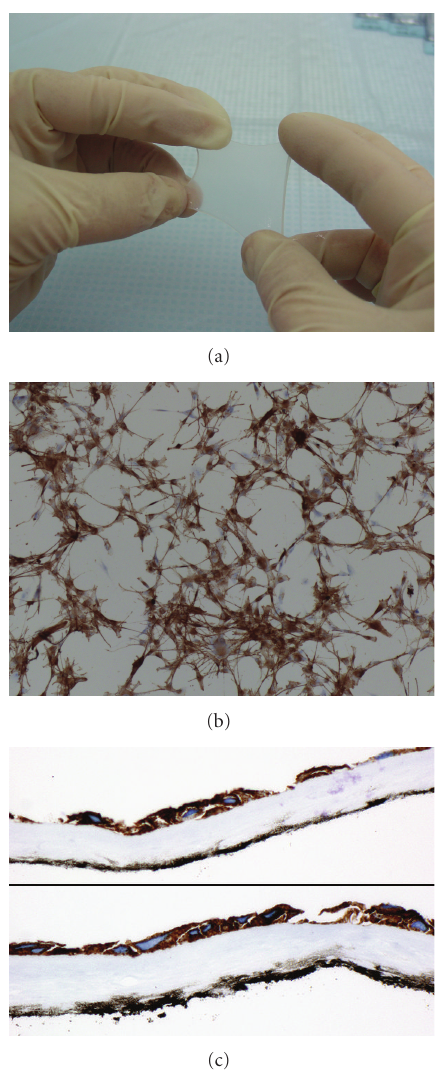
Figure 1: Piece of amniotic membrane (a); immunohistochemistry for HMB-45 applied to cells cultured on slide. A large number of melanocytes can be observed (b); micrograph of cross-sectioned AM stained with HMB-45 after cell culture (c). Original magnifi- cation: (b, c)